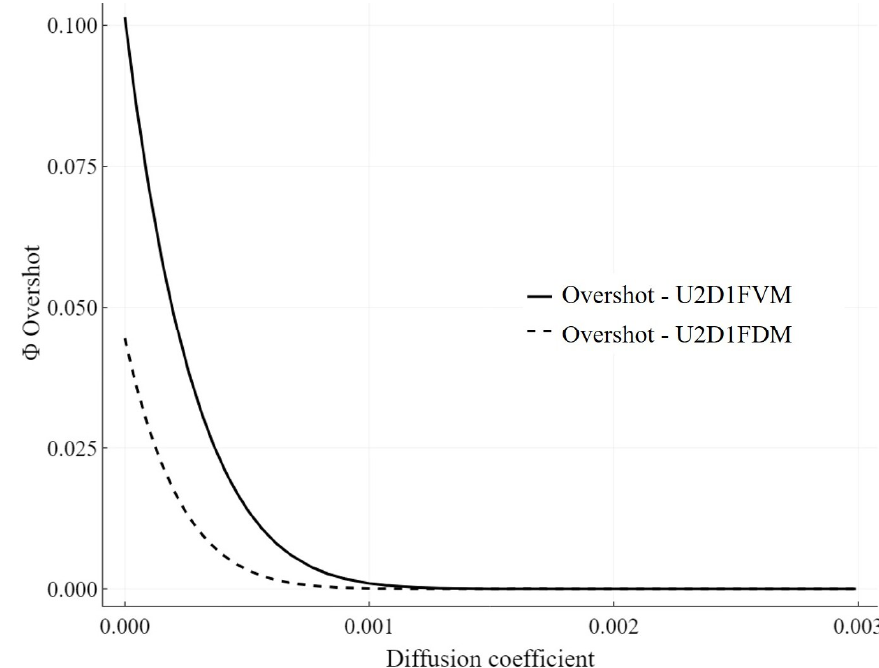
Figure 5. Effect of physical diffusion on unphysical oscillation on sharp interfaces for n a = 100 (the critical Peclét number, which makes the residual oscillation less than 10 −6 . It is approximately 6.47 for the U2D1FVM and 8.51 for the U2D1FDM).